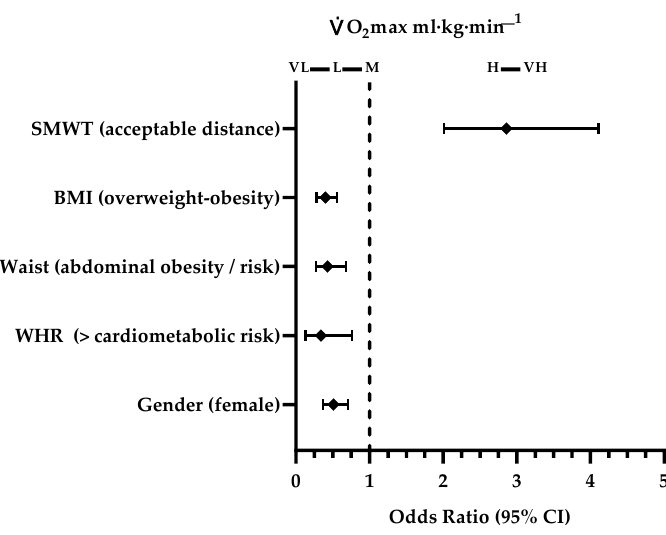
Figure 1. Association between the V ̇ O 2 max, gender, basic anthropometry, and SMWT. On the other hand, female students were less likely of having an acceptable distance in the SMWT compared to male students (OR: 1.0 [95% IC: 0.73; 1.37], p = 0.975), and neither did the students who presented a higher cardiometabolic risk according to WHR (OR: 0.62 [95% IC: 0.32; 1.24], p = 0.143), regarding those with a lower cardiometabolic risk (Figure 2).